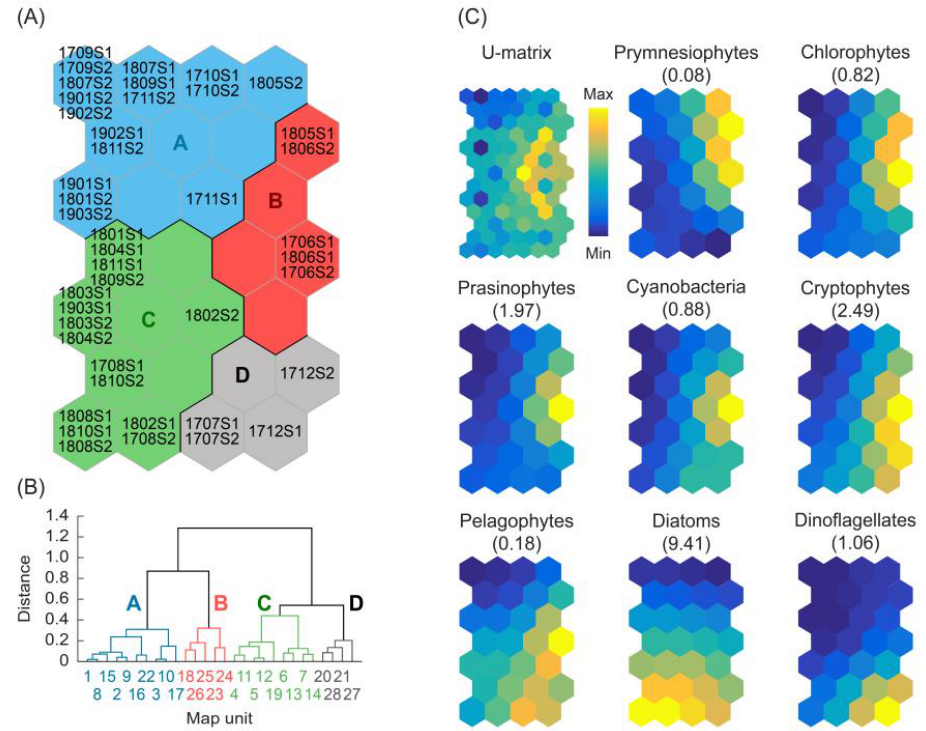
Figure 4. Patterning of the phytoplankton communities on the Kohonen self-organizing map (SOM). Log-transformed concentrations of phytoplankton taxonomic groups were used for SOM training.